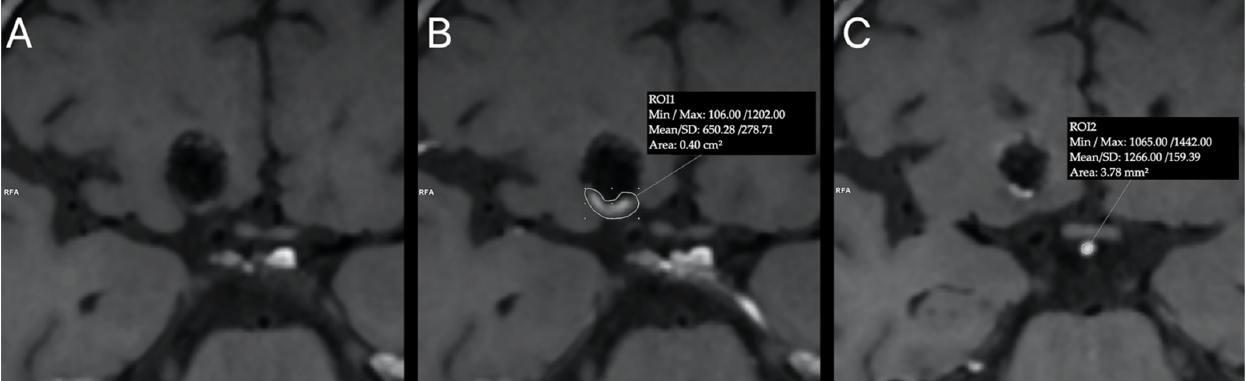
Figure 1. Example of region of interest (ROI) placement for quantitative analysis of post-procedural aneurysm contrast enhancement intensity. Precontrast ( A ) and postcontrast ( B , C ) HR-VW MRI of right internal carotid artery aneurysm treated with stent-assisted coiling. ROI drawn manually around the area of peripheral aneurysm contrast enhancement ( B ). Second ROI positioned within the pituitary stalk ( C ).